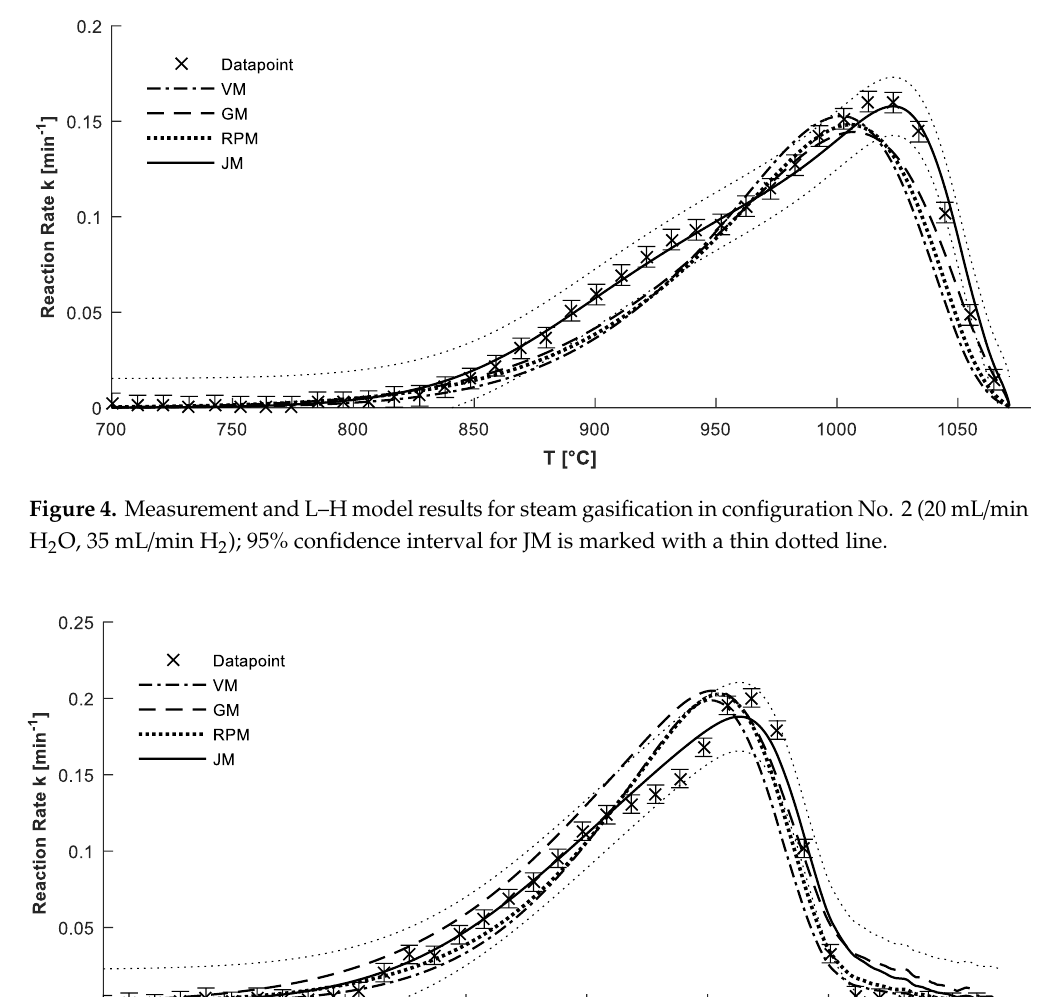
Figure 4. Measurement and L–H model results for steam gasification in configuration No. 2 (20 mL/min H₂O, 35 mL/min H₂); 95% confidence interval for JM is marked with a thin dotted line.